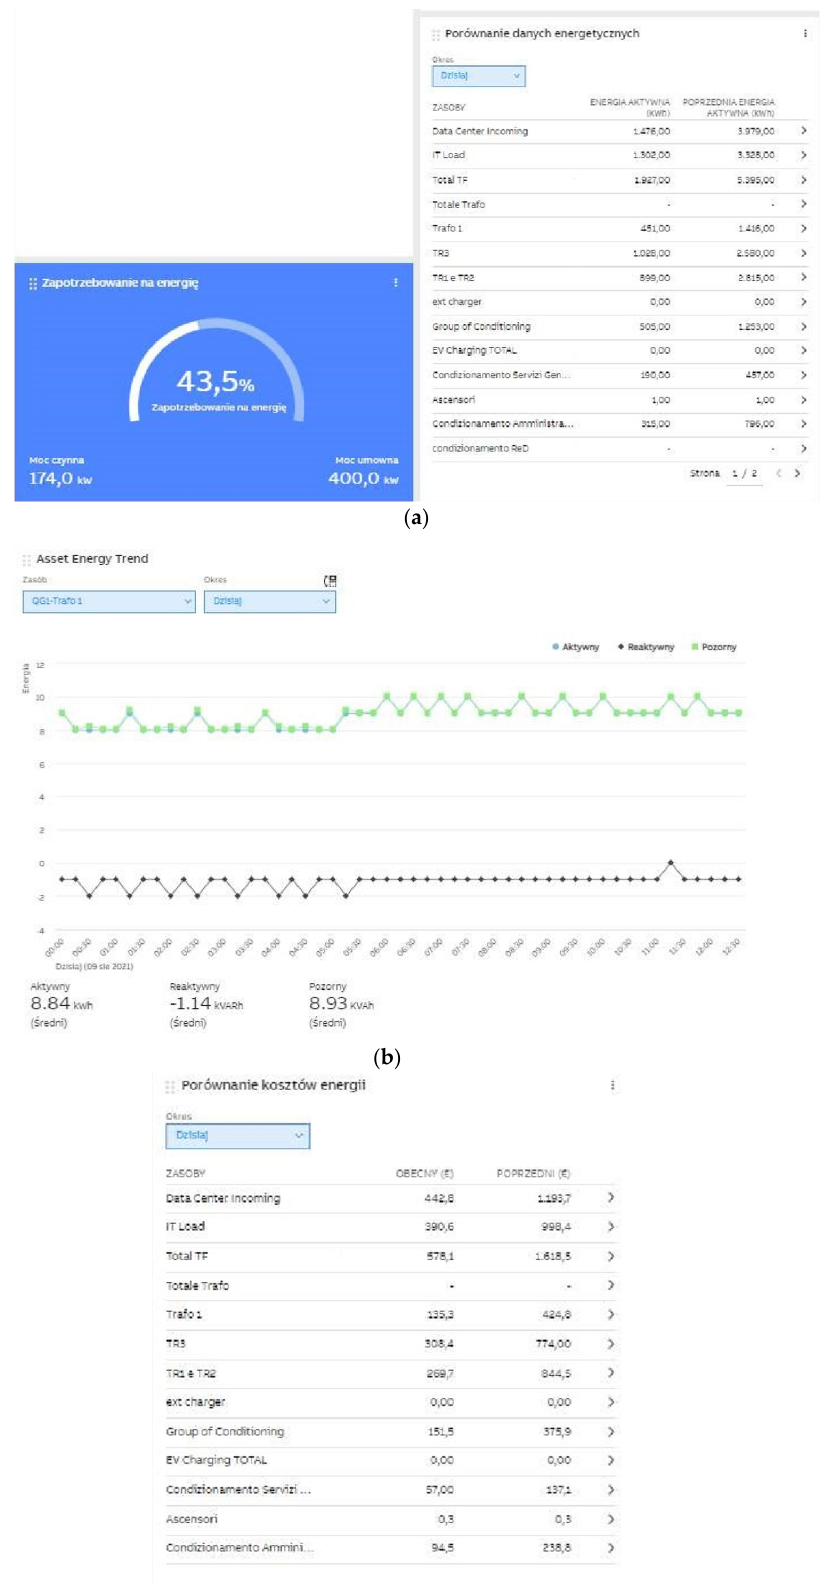
Figure 14. Visualization of the switchgear under constant online supervision.